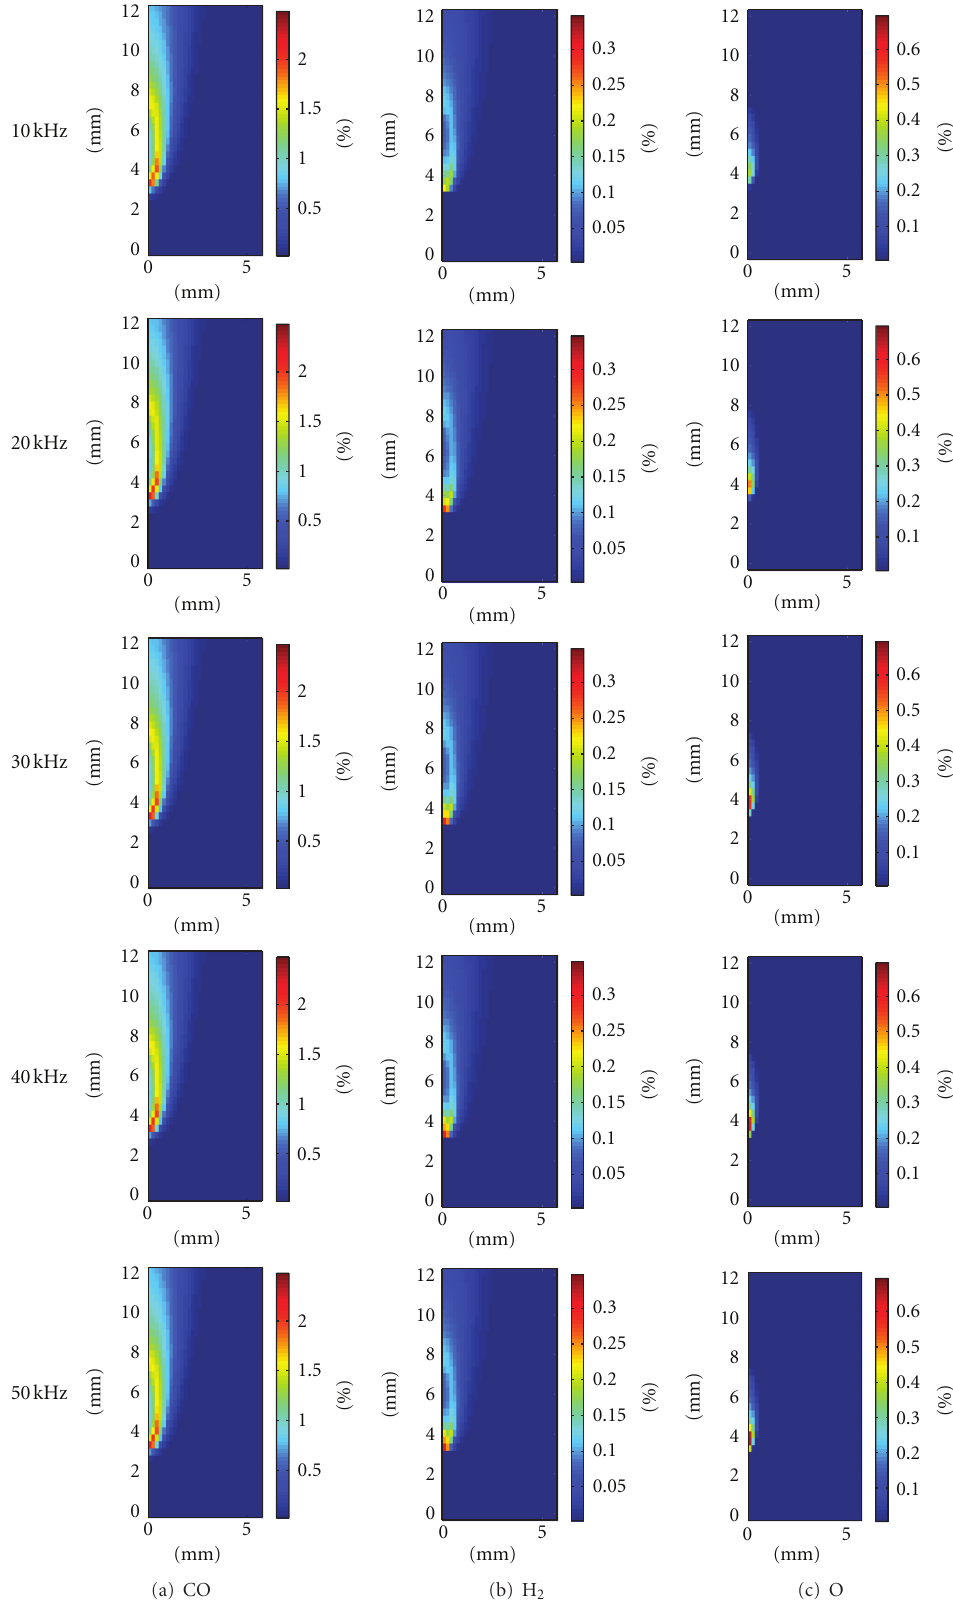
Figure 4: Quasi-steady state spatial distribution of (a) CO, (b) H 2 , and (c) O for di ff erent repetition rates of 10 kHz, 20kHz, 30kHz, 40 kHz, and 50 kHz at 9ns pulse